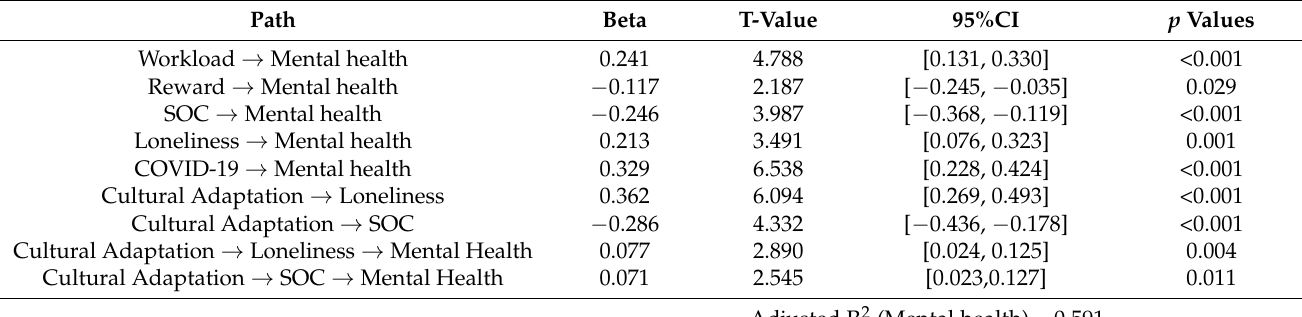
Table 5. Direct and indirect effects predicting mental health of foreign care workers (n =